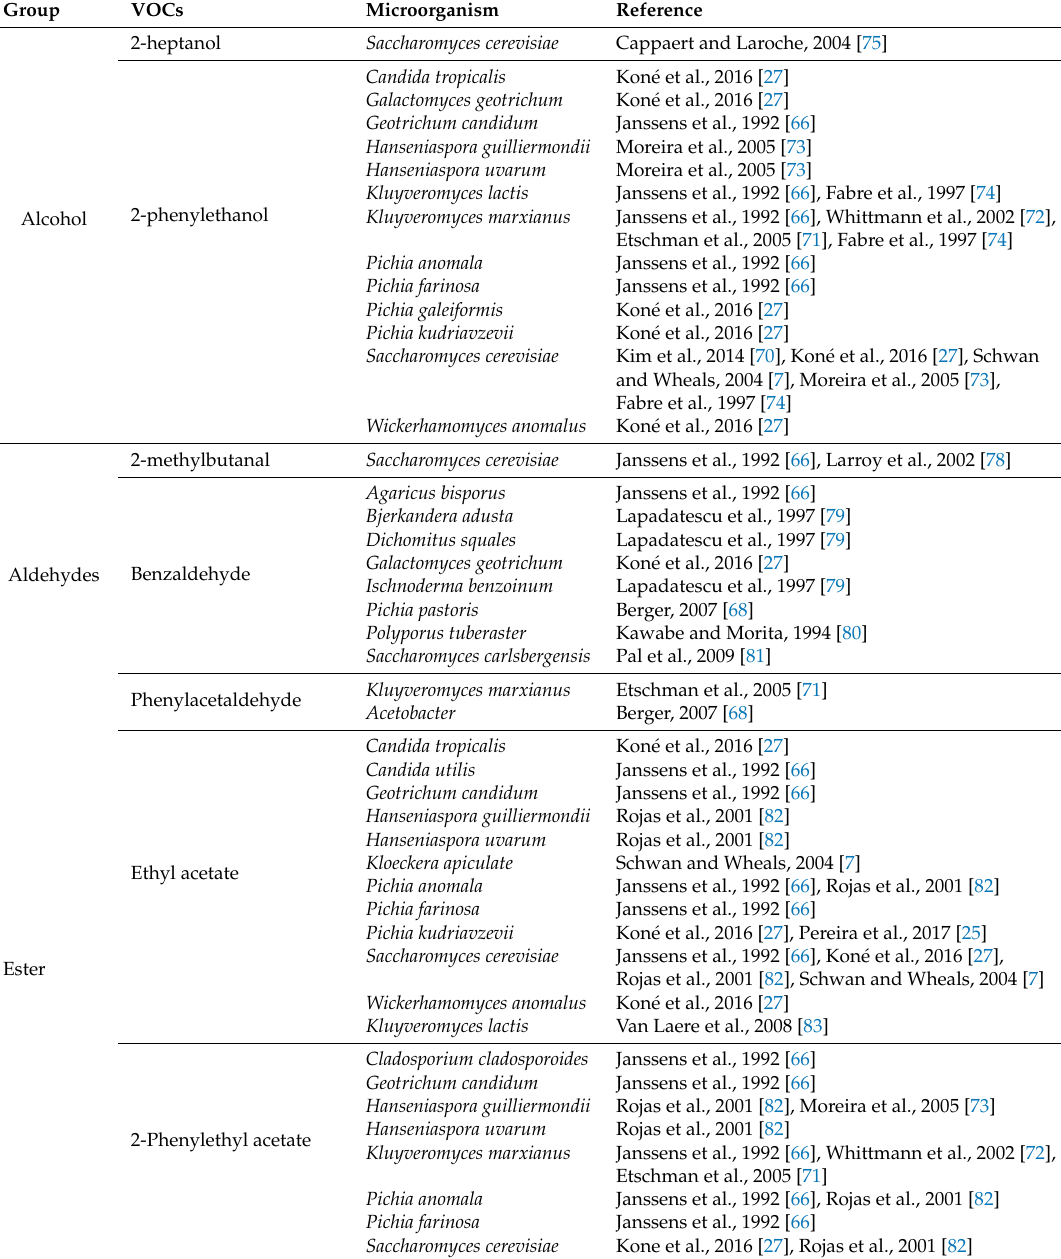
Table 5. Summary table of the yeast producer of selected key aromatic compounds in cocoa